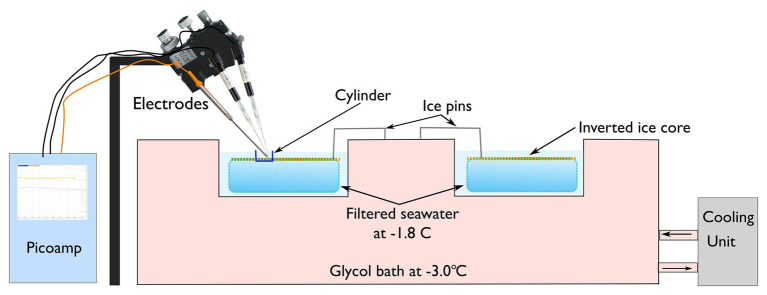
Ice cores were inverted and placed within individual chambers and then submerged in filtered seawater at a temperature of −1.8 ± 0.5°C. Three microelectrodes [hydrogen peroxide (H2O2), nitric oxide (NO), and oxygen (O2)] were manipulation in place above the inverted ice core containing the algal mat.